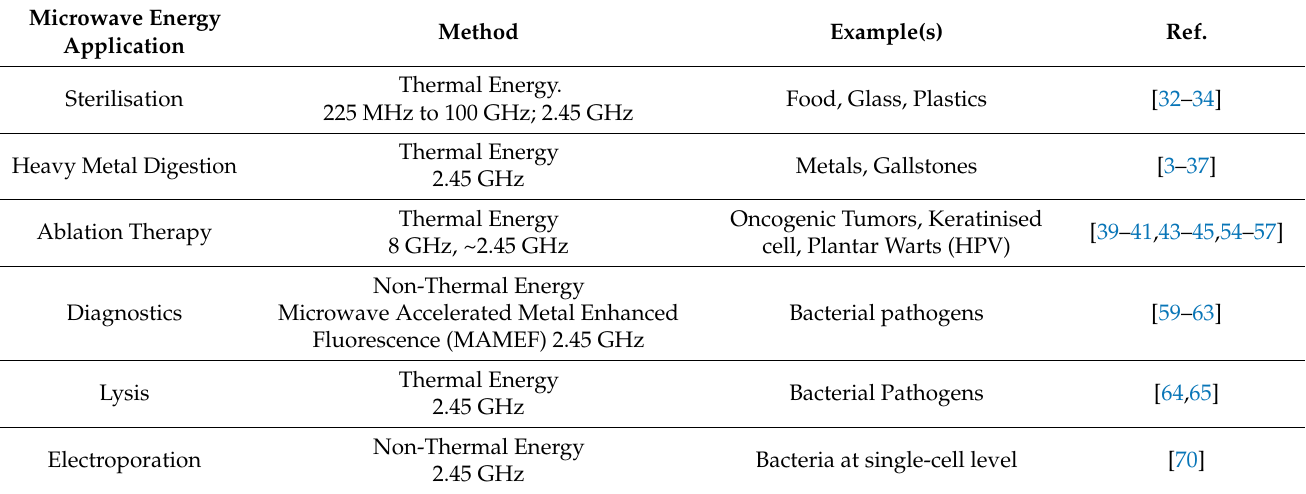
Table 1. Summary of Microwave Applications in